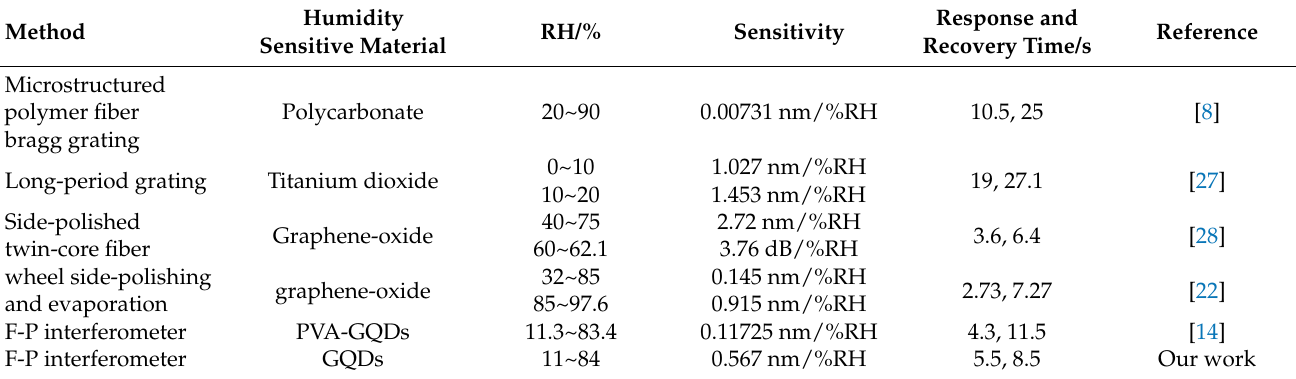
Table 1. Comparison of other fiber optic humidity